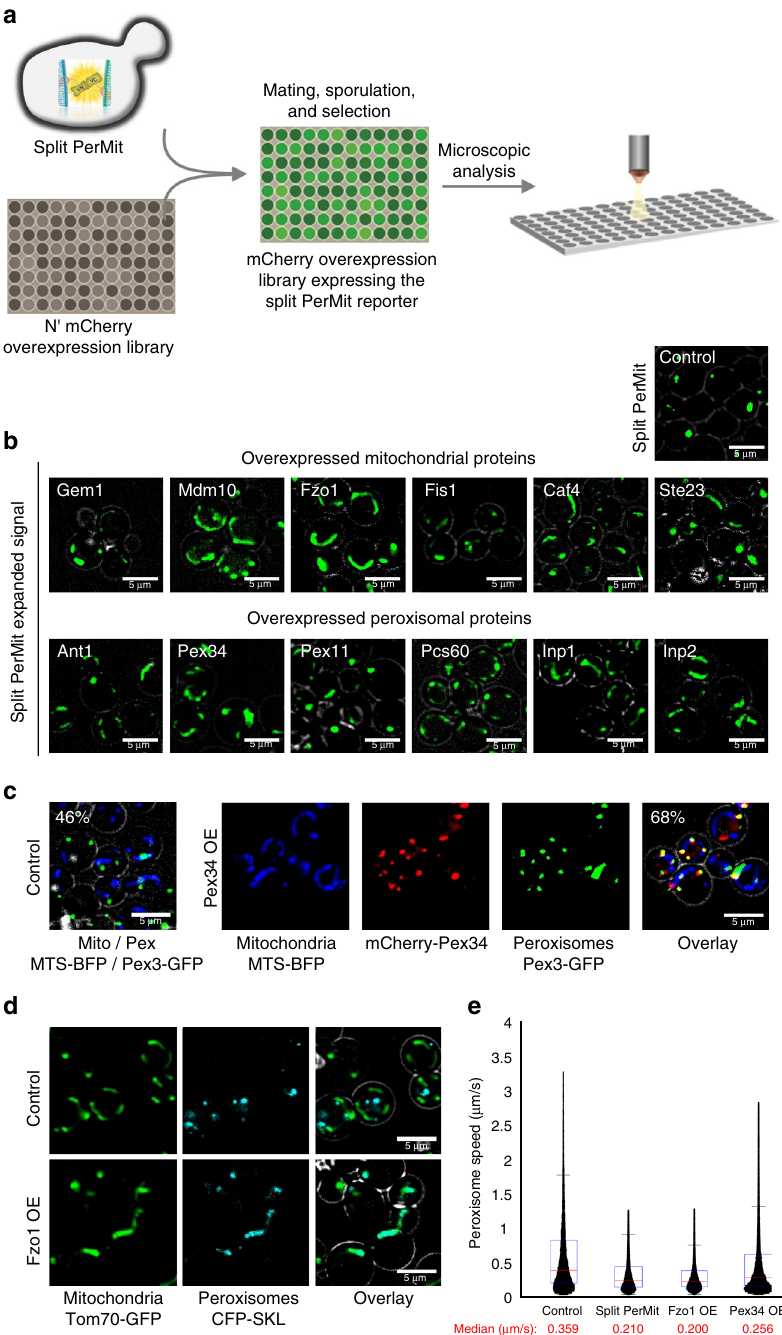
Fig. 3 A high content microscopy screen reveals proteins that expand the PerMit reporter signal when overexpressed. a A schematic representation of the microscopy screen. Yeast strains carrying the PerMit reporter were mated with a collection of strains each expressing one protein tagged with a mCherry fl uorophore while being expressed under a strong, TEF2 , promoter. Haploid cells carrying the reporter and an overexpressed protein tagged with mCherry were analyzed using a fl uorescent microscope aiming to fi nd strains in which the reporter signal was expanded. b Representative images of either mitochondrial or peroxisomal genes whose overexpression led to the expansion of the PerMit reporter signal. c Pex34 overexpression (Pex34 OE) leads to increased co-localization of peroxisomes (marked by Pex3-GFP) to mitochondria (marked by MTS-BFP) independently of the presence of the PerMit reporter. White numbers — percentage of peroxisomes that co-localize with mitochondria. d Fzo1 overexpression (Fzo1 OE) leads to peroxisomes (marked by CFP-SKL) clumping onto mitochondria (marked by Tom70-GFP) in the absence of the PerMit reporter. e Mean peroxisome speed was calculated from 4 min time-lapse videos of strains carrying marked peroxisomes (CFP-SKL) without (control) or with the PerMit reporter and in Fzo1 OE or Pex34 OE cells without the PerMit reporter. Boxplots are shown with 25,000 point distributions from three independent experiments. Red lines indicate the median (the median values are written beneath each strain name). Bottom and top edges of the blue boxes indicate the 25 and 75 percentiles. The whiskers extend to the most extreme data points, not considering the outliers. The analysis shows that the PerMit reporter itself, as well as overexpression of Fzo1 or Pex34, reduce peroxisome